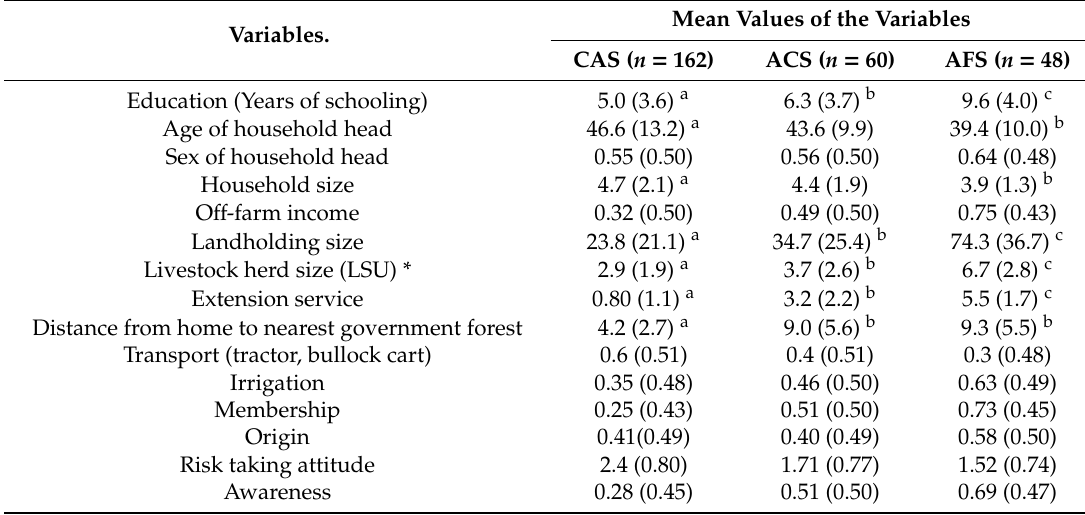
Table 2. Characteristics of sample households in the study